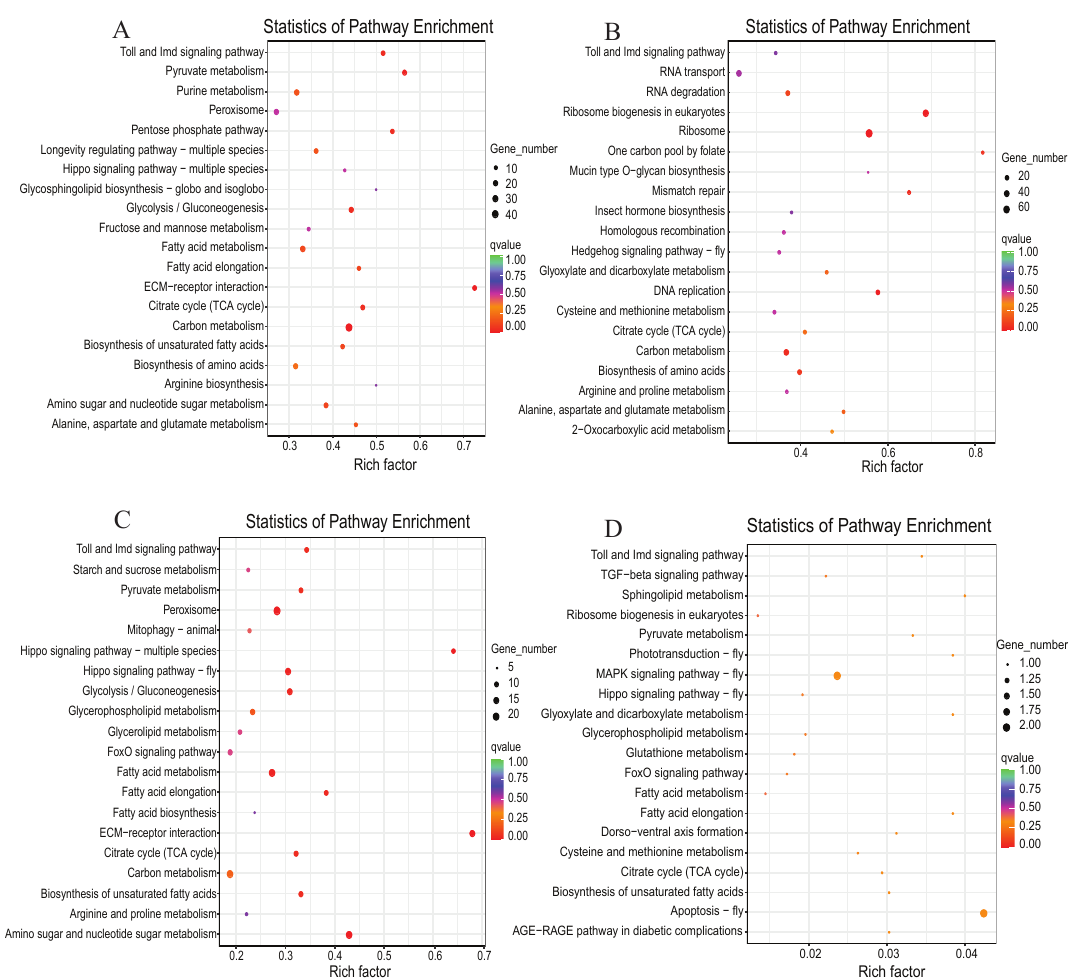
Figure 4. Enrichment and dispersion point map of differentially expressed genes (DEGs) in KEGG pathways. ( A ) The DEGs involved in the pathways after challenge for 24 h vs. 0 h; ( B ) the DEGs involved in the pathways after challenge for 24 h; ( C ) the DEGs involved in the pathways after challenge for 48 h vs. 0 h; ( D ) the DEGs involved in the pathways after challenge for 48 h. The circles in the graph indicate that the KEGG pathway with the gene number and enrichment factor (q-value, different colors) are displayed on the y and x axes,